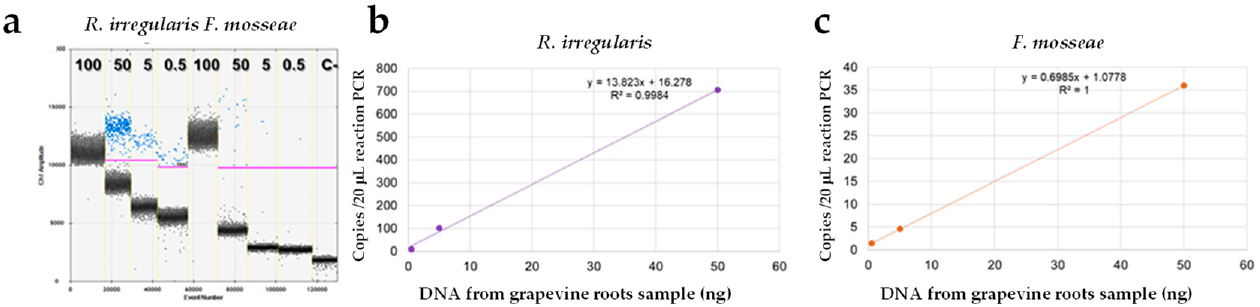
Figure 6. Several dilutions (100, 50, 5, 0.5 ng) of DNA from sample I10 analysed for R. irregularis and F. mosseae genes ( a ). The leftmost ddPCR reaction (100 ng) was saturated by an excess target concentration and the rightmost reaction contains a minimal copy of the target. The respective regression line of serial dilution was shown ( b , c ). C- = negative control.